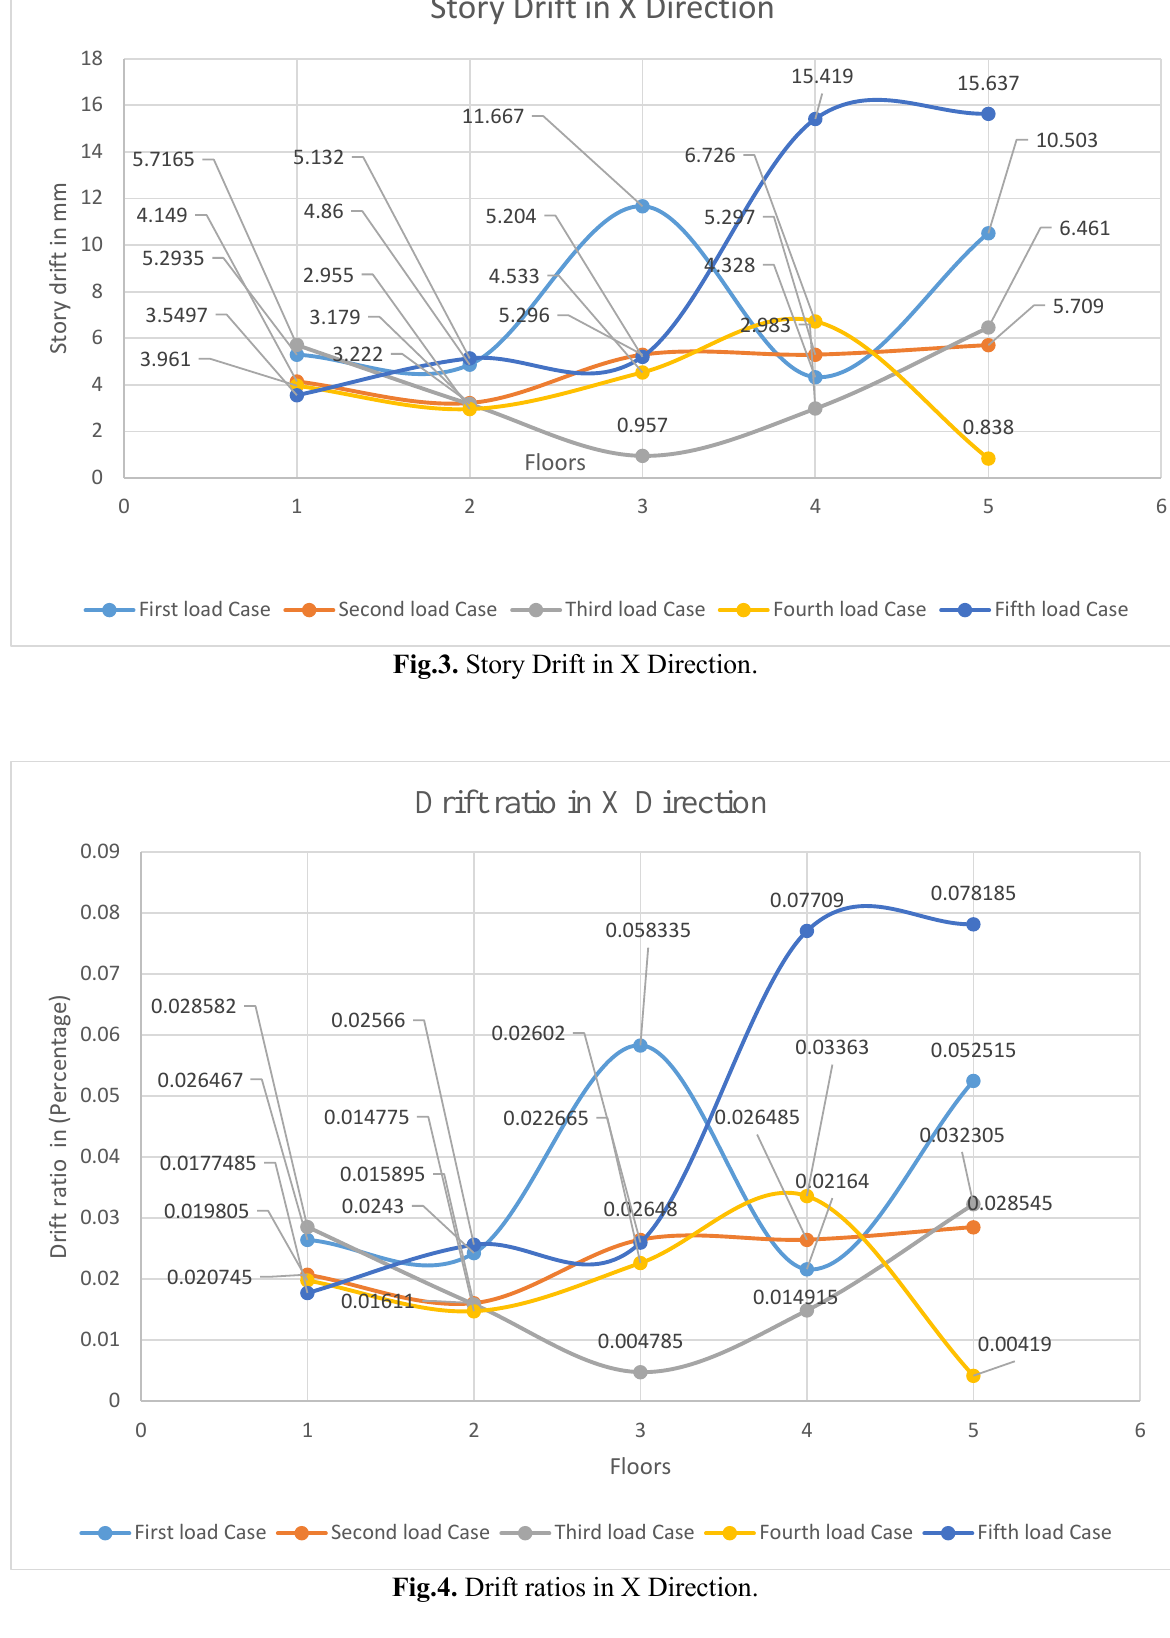
Fig.4. Drift ratios in X